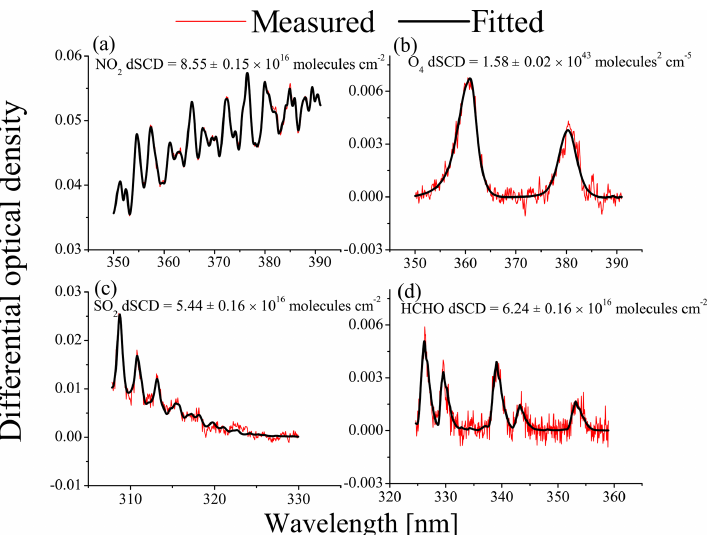
Figure 2. Examples of typical DOAS fits of NO 2 (a) , O 4 (b) and SO 2 (c) at 11:37LT on 1 December 2011 as well as HCHO (d) at 11:34LT on 12 July 2012. The fitted dSCDs of NO 2 , O 4 , SO 2 and HCHO are given in the corresponding subfigures. The black and red curves indicate the fitted absorption structures and the derived absorption structures from the measured spectra,